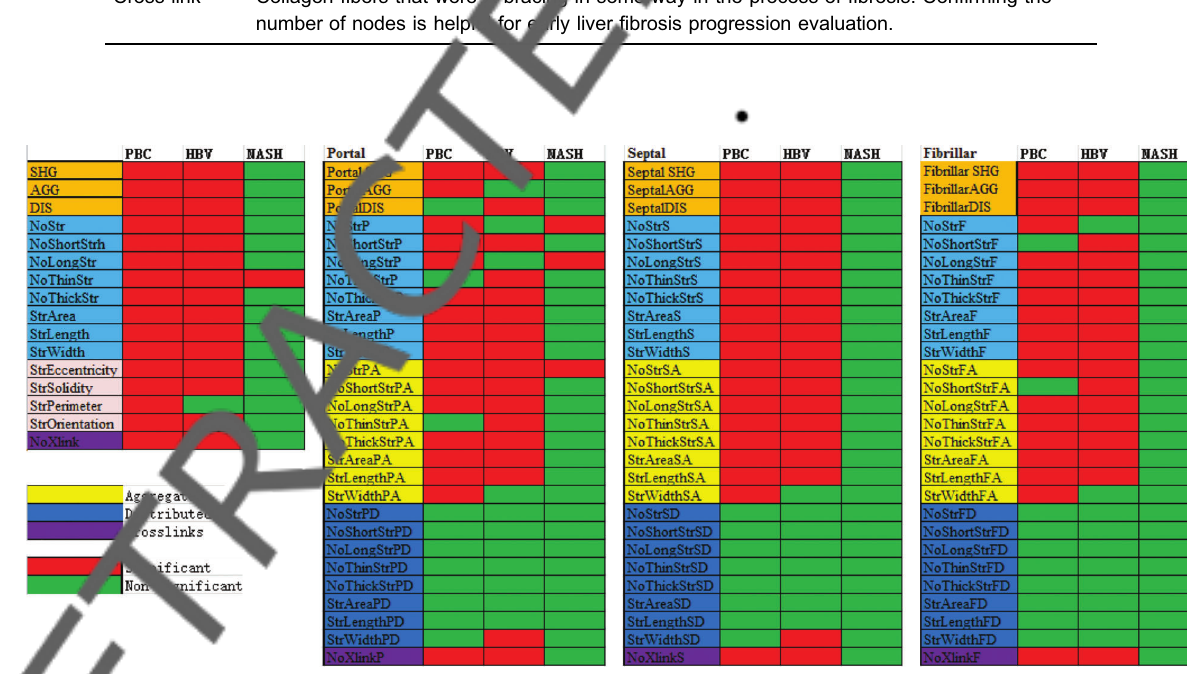
Figure 1. Results of one-way ANOVA analysis of parameters in portal, septal and fi brillar areas with liver fi brosis stages in samples from chronic hepatitis B (CHB), primary biliary cirrhosis (PBC), and non-alcoholic steatohepatitis (NASH). Orange, light blue and gray colors are used for differentiation of different parameters. SHG, second harmonic generation; AGG: aggregated collagen percentage; DIS: distributed collagen percentage. See Supplementary Table S1 for details.